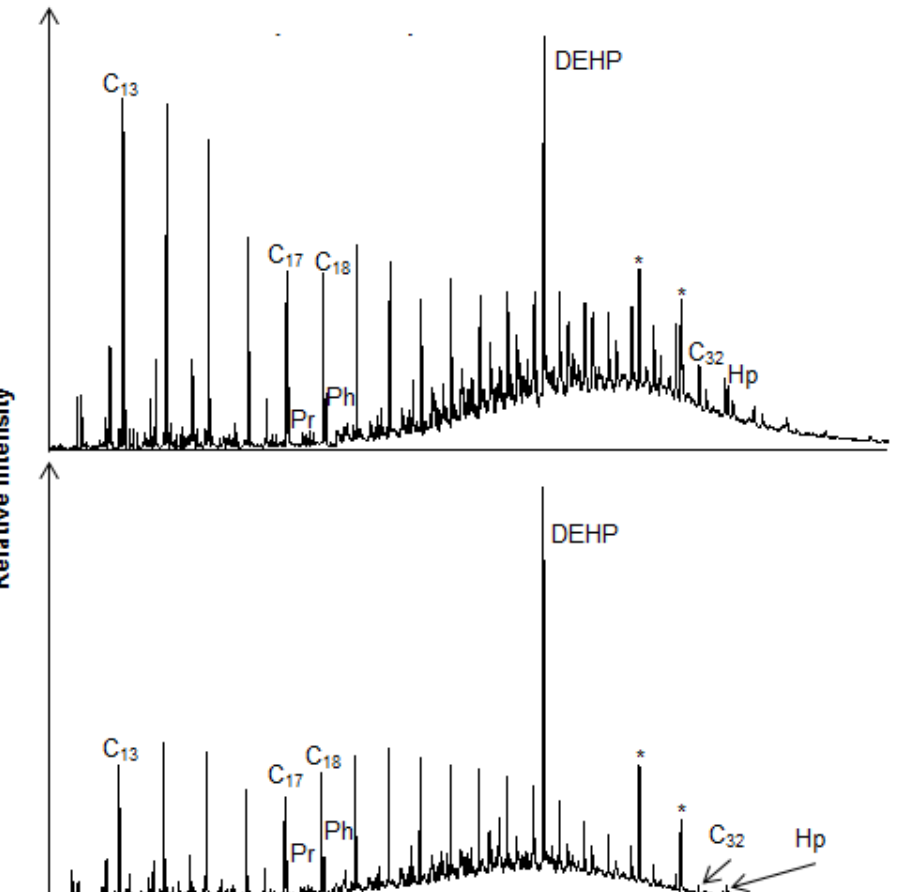
Figure 5. Single ion mode (SIM) chromatogram of ion ( m / z ): 57 representative of alkanes of the study soil at the beginning (top) and after 15 days of treatment (bottom; control treatment). Ci—n-alkanes of the “i" carbons chain. Pr—Pristane; Ph—Phytane; Hp—Hopanes; DEHP—Bis(2-ethylhexyl)phthalate * procedure